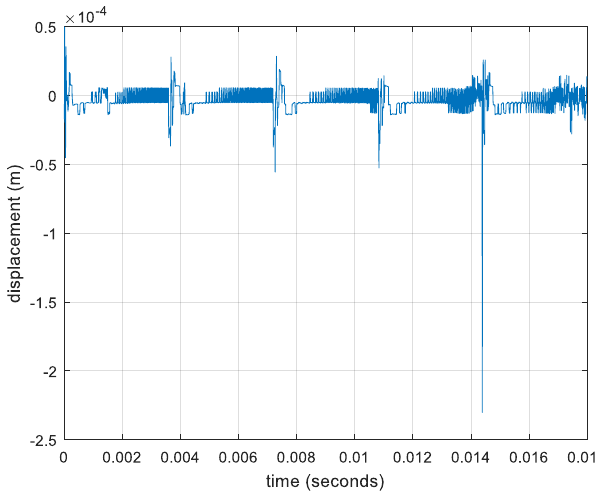
Figure 15. Vibration in time domain (machine with eccentricity fault).